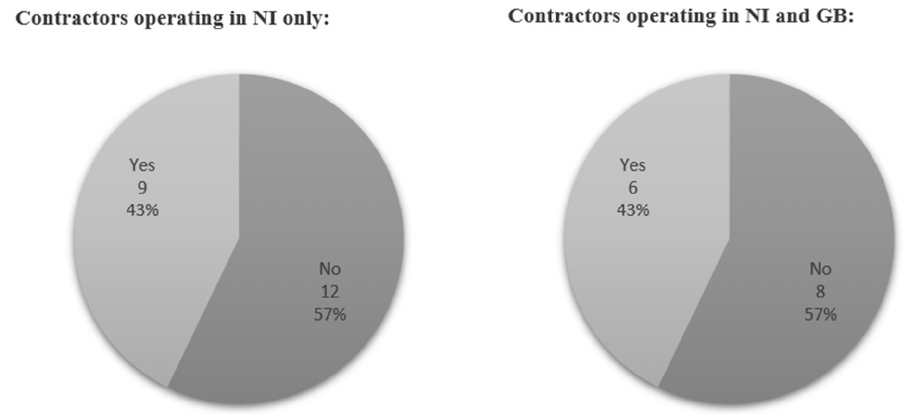
Figure 10. Count of responses to the question “In the past 7 years, have you challenged the award of any public procurement exercise?”, broken down by organisation’s area of operation. In general, there is more of a bias towards fewer than expected, with perhaps a sur- prising number saying the number is as they would expect. However, the bias towards fewer challenges than expected suggests that procurement in NI is be tt er managed than the industry perceives.